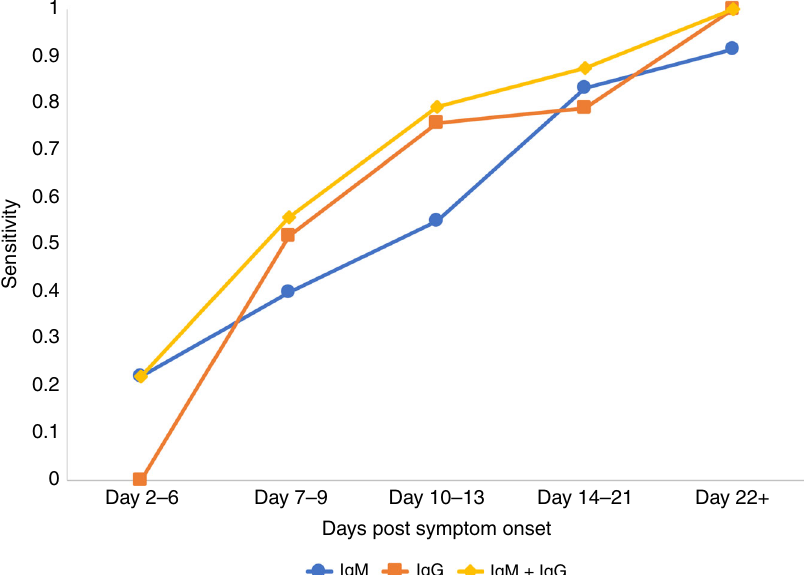
Fig. 4 Sensitivity of CoVAM as a function of time since symptom onset. The sensitivity in detecting SARS-CoV-2 antibody responses in PCR-positive individuals is shown as a function of time since symptom onset for IgM, IgG, and either IgM or IgG. Source data are provided as a Source data fi